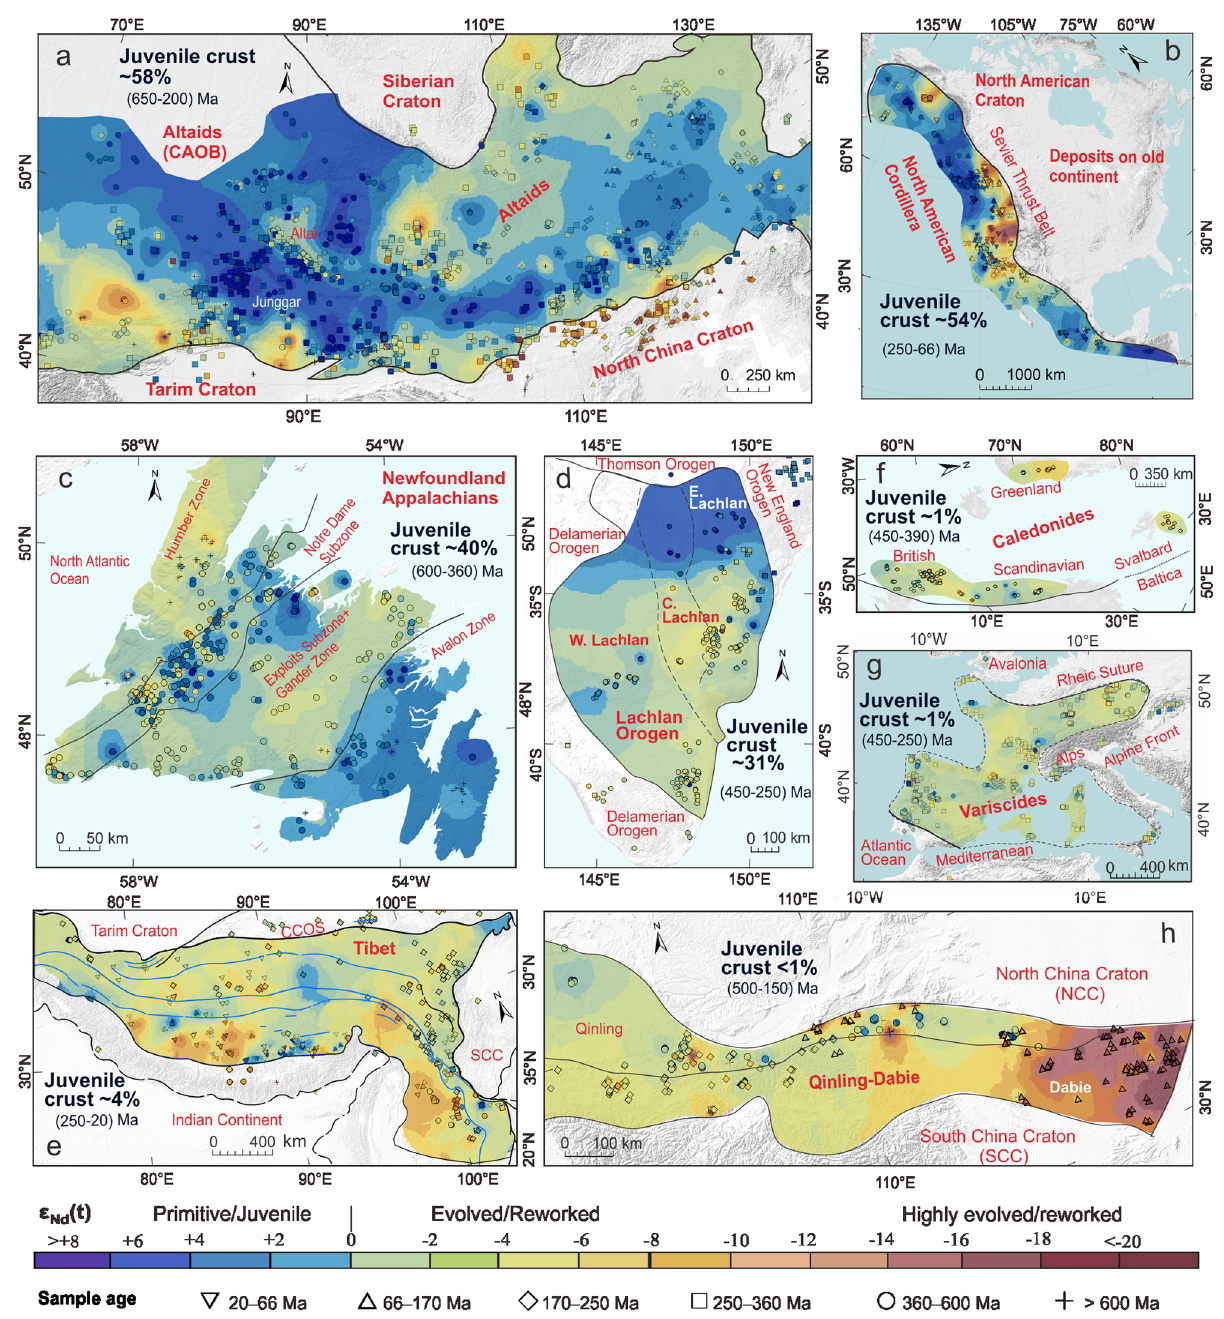
Fig. 2 ε Nd (t) contour maps of the eight orogens. a Altaids, b North American Cordillera, c Newfoundland Appalachians, d Lachlan, e Tethyan Tibet, f Caledonides, g Variscides, and h Qinling-Dabie orogens, showing spatial variations of ε Nd (t) values and distribution of Nd isotopic domains. The lower row legend shows the colors expressed as variations in ε Nd (t) values. E. = Eastern; C. = Central; W. = Western. See the explanations and uncertainties in the text and dataset in Supplementary Data 1 – 8. The digit topographic map comes from